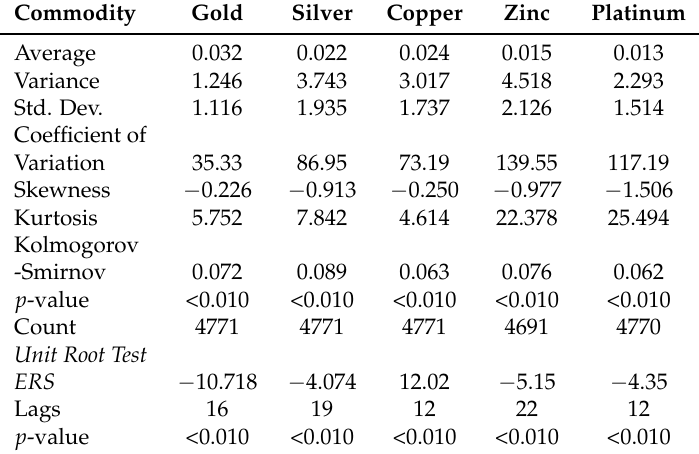
Table 1. Summary statistics of (log) front month future price